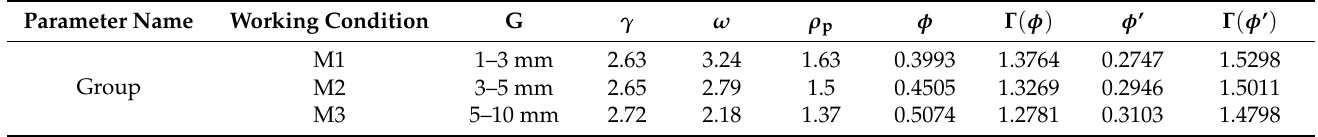
Table 1. Calculation parameters of the porous media.